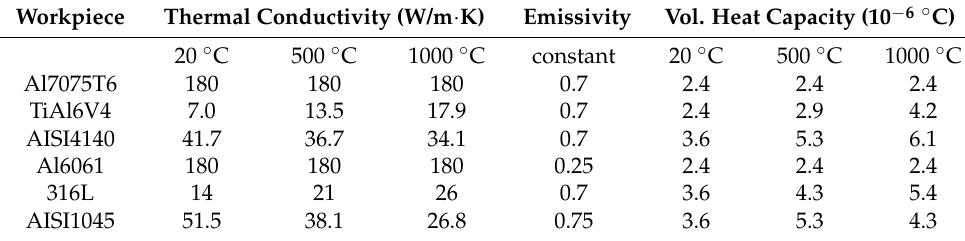
Table 3. Thermal material properties used in the